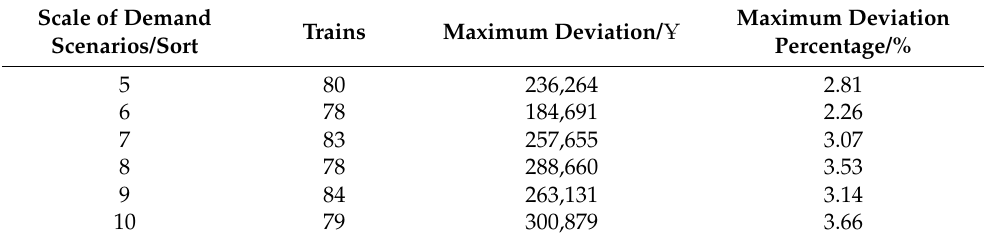
Table 6. The maximum deviation value and maximum deviation percentage between the robust scheme and the satisfactory scheme under each scale of the demand